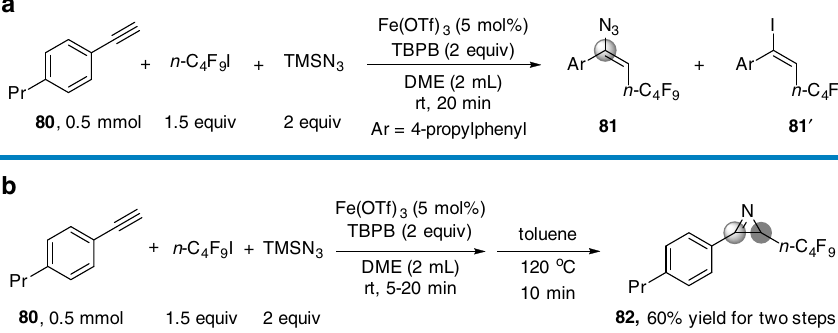
Fig. 6 Carboazidation of alkynes. a Optimized reaction conditions. b Cascade transformation of vinyl azide to 2 H -azirine